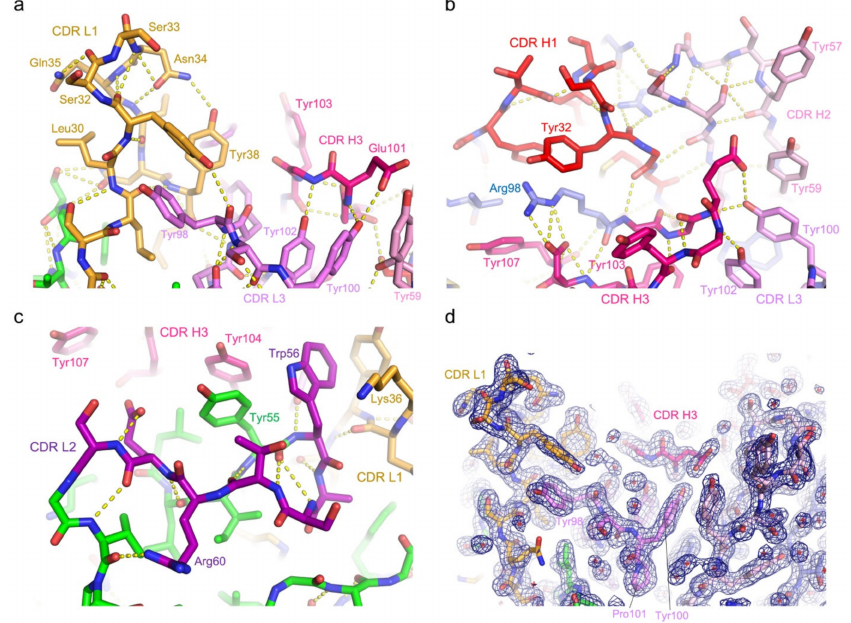
Figure 4. Network of hydrogen bonds stabilizing the CDR loops. ( a – c ) Close-up views of three different regions showing the extensive network of hydrogen bonds to stabilize the CDR loops. ( d ) 2mFo-DFc electron density map contoured at 1.0 σ overlaid on the atomic